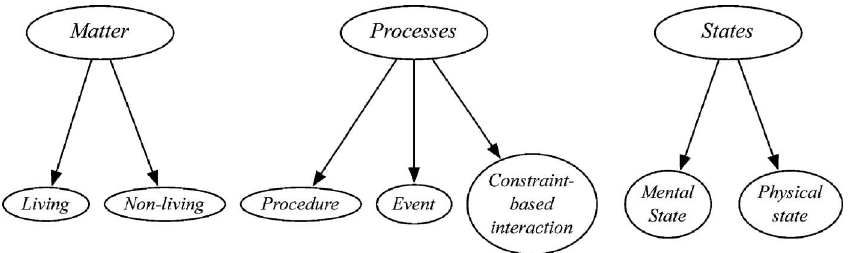
FIG. 1. Revised ontology tree based on